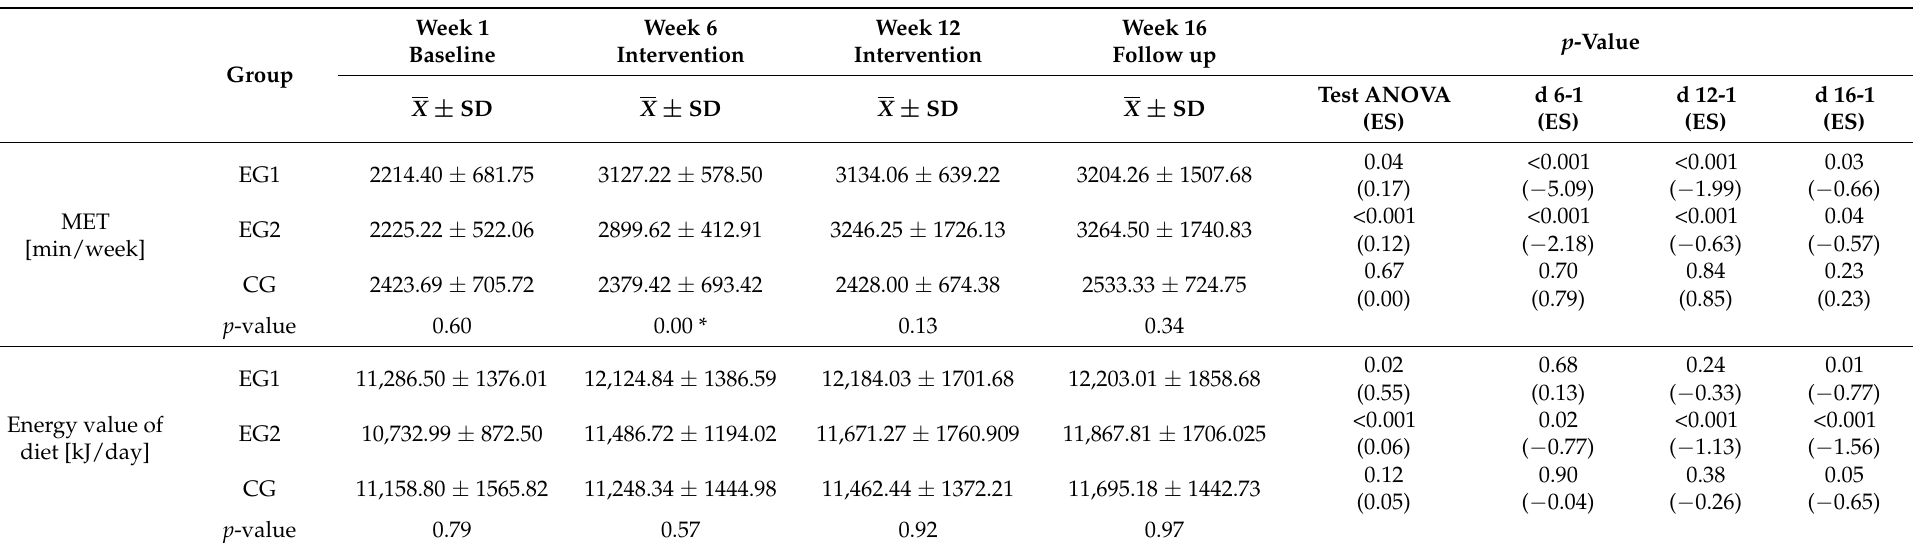
Table 1. Metabolic equivalent of task (MET) and energy value of the research participants’ diet in the aerobic group (EG1), aerobic-resistance group (EG2), and control group